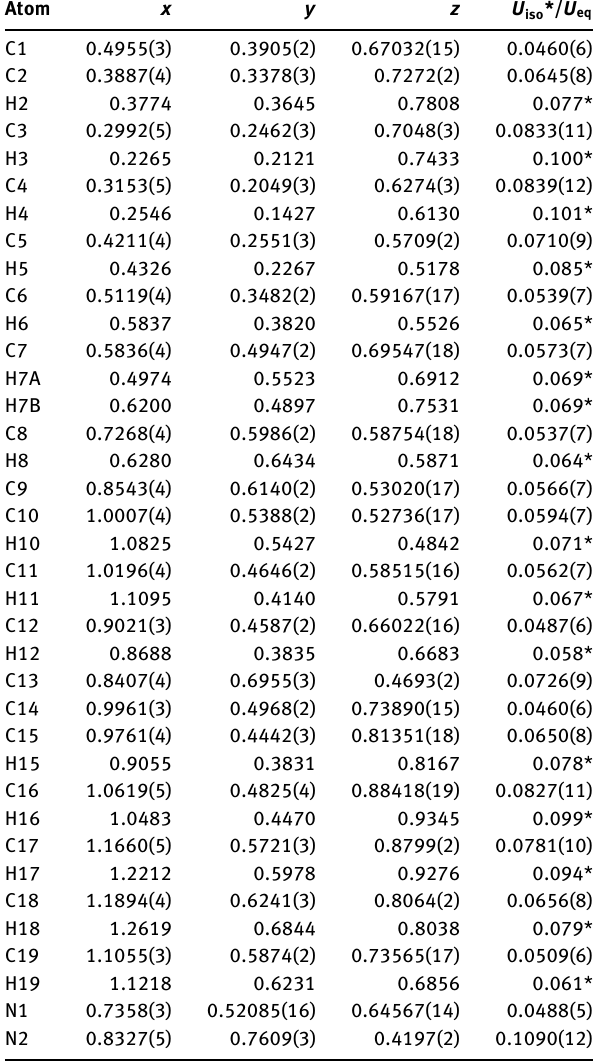
Table 2: Fractional atomic coordinates and isotropic or equivalent isotropic displacement parameters (Å 2